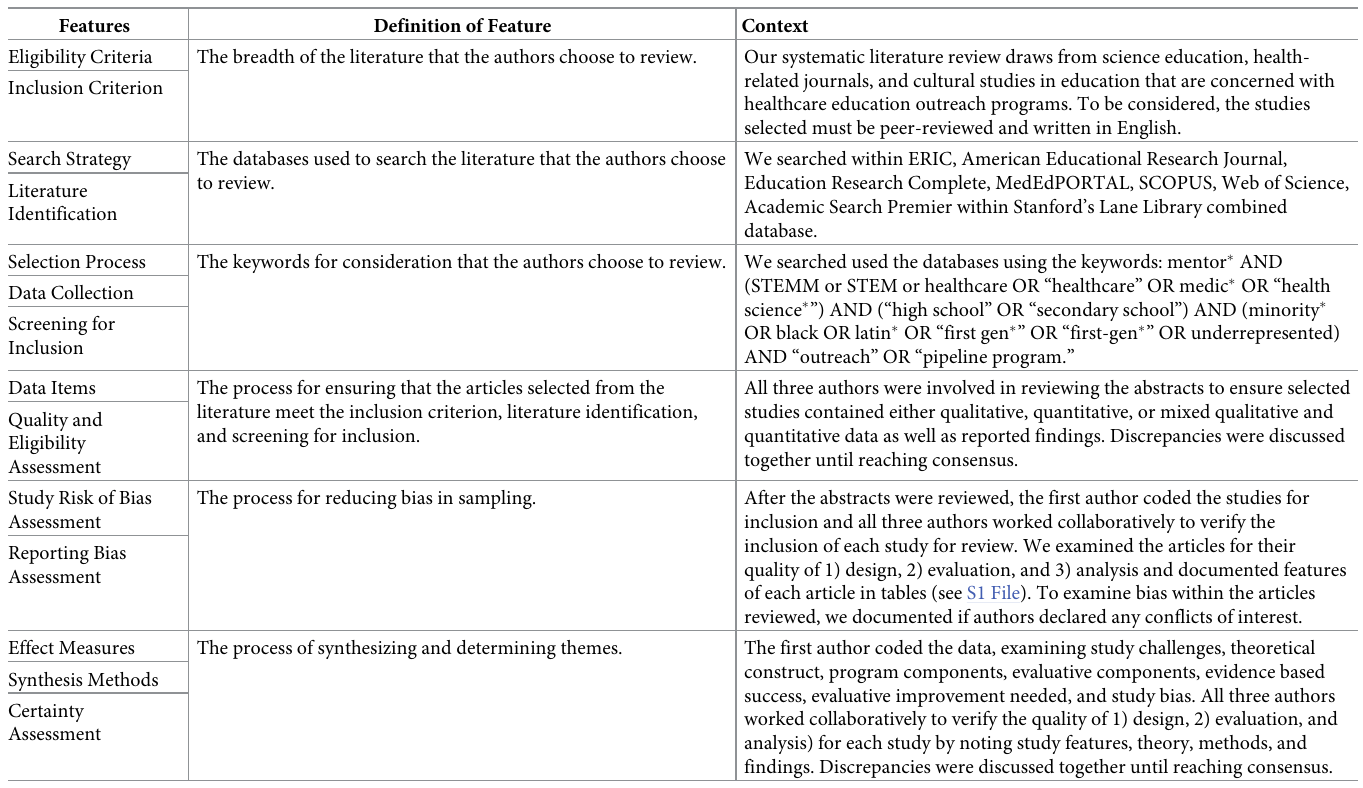
Table 1. Features of a systematic literature review and